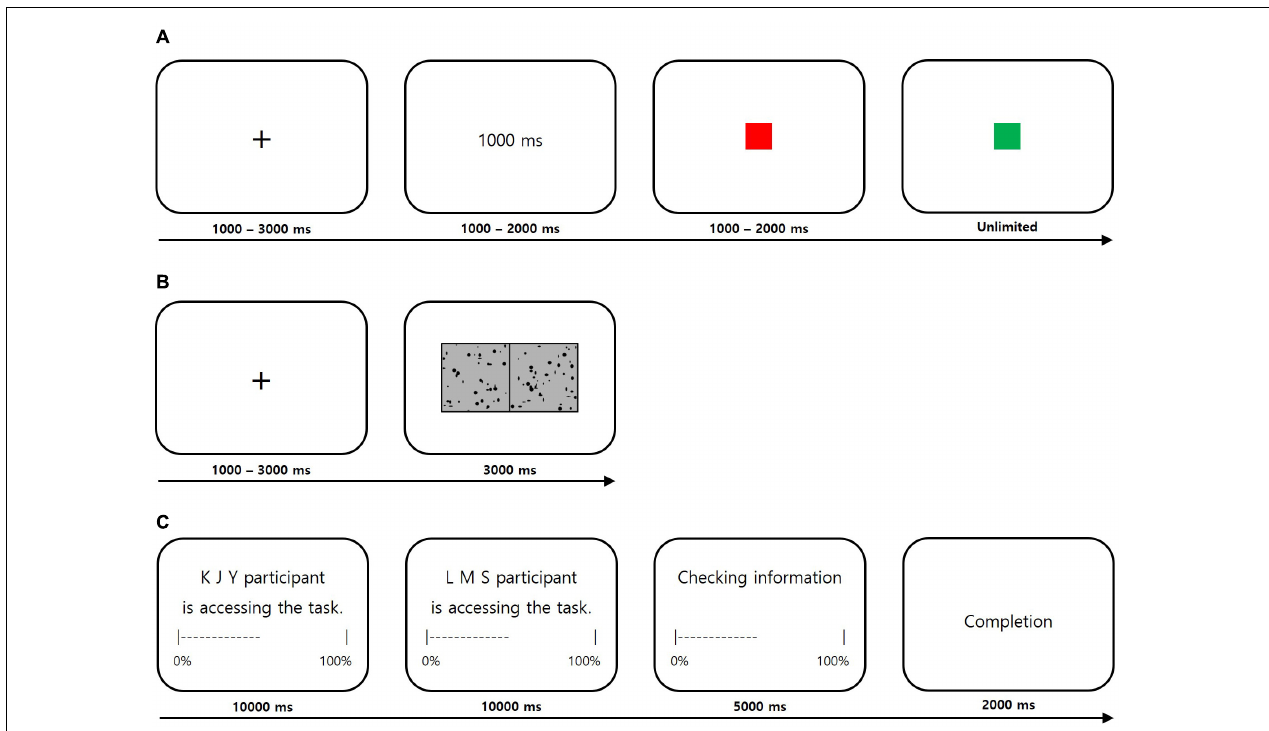
FIGURE 1 | Schematic diagram of the behavioral tasks used in the social hierarchy manipulation. (A) The time estimation task. (B) The visual discrimination task. (C) Participants viewed that two other participants in separate laboratories were accessing an online game to maintain the believability of the interaction between each